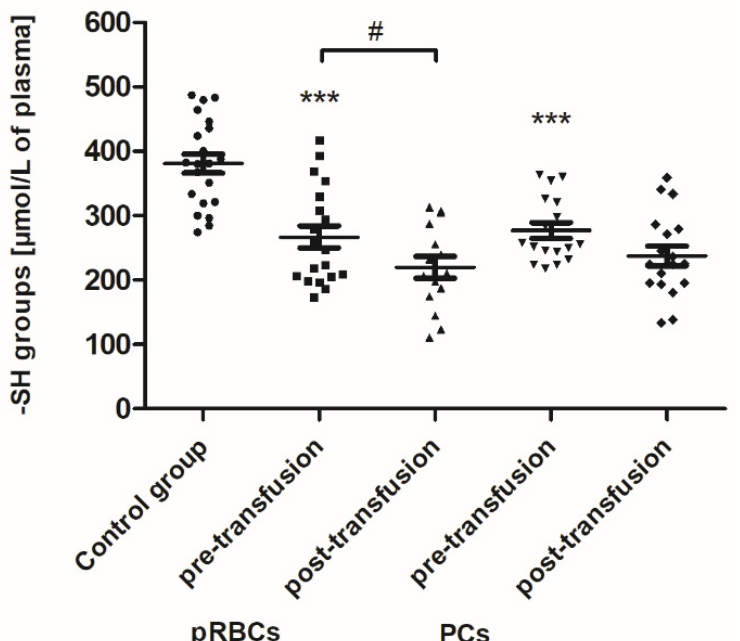
Figure 1. The concentration of total thiols in the plasma of healthy volunteers (control group) and AML patients before and after transfusion of the blood component. Scatter plots show all of the data values obtained. Data are presented as mean ± SE. *** p < 0.001 compared to the control group; # p < 0.05 compared post-versus pre-transfusion; statistically significant according to the Tukey test. pRBCs—packed red blood cells; PCs—platelet concentrates.